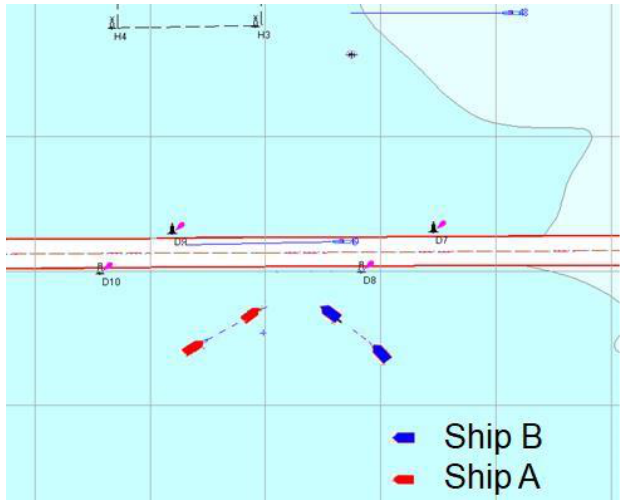
Figure 5. Experiment area with the tracks of ship A and ship B.